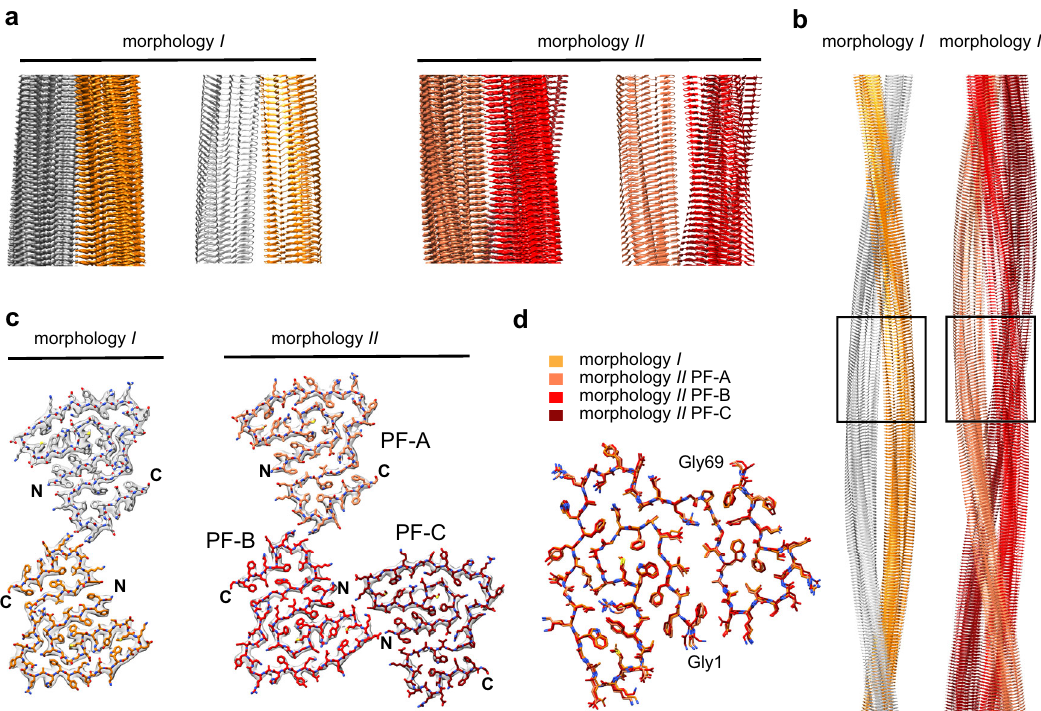
Fig. 1 Cryo-EM structures of AA amyloid fi brils puri fi ed from diseased tissue. a Side views of fi bril morphologies I and II: corresponding segments of the 3D maps and models, shown as ribbon diagrams. b Models of fi brils in side view. The segment shown in a is boxed. c Cross-sectional layers of fi bril morphologies I and II. The 3D maps (gray surfaces) are superimposed with the models, shown as sticks. d Alignment of the fi bril proteins of morphology I and II (PF-A to PF-C) as indicated in the fi gure. The data of morphology I is taken from a previously deposited data (PDB 6DSO: https://doi.org/10.2210/ pdb6dso/pdb) 50 .